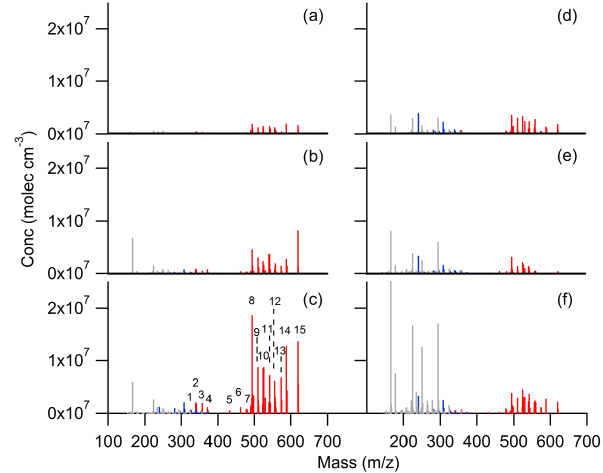
Fig. 4. Time-dependent spectra of all category products between 100 and 700amu measured with the Cluster CIMS for E1. (a–f) correspond to times a–f in Fig. 1b. Color codes: red – Category I products; blue – Category II products; gray – Category III products. Number 1–15 in Fig. 4c corresponds to different peak classifications (see text for